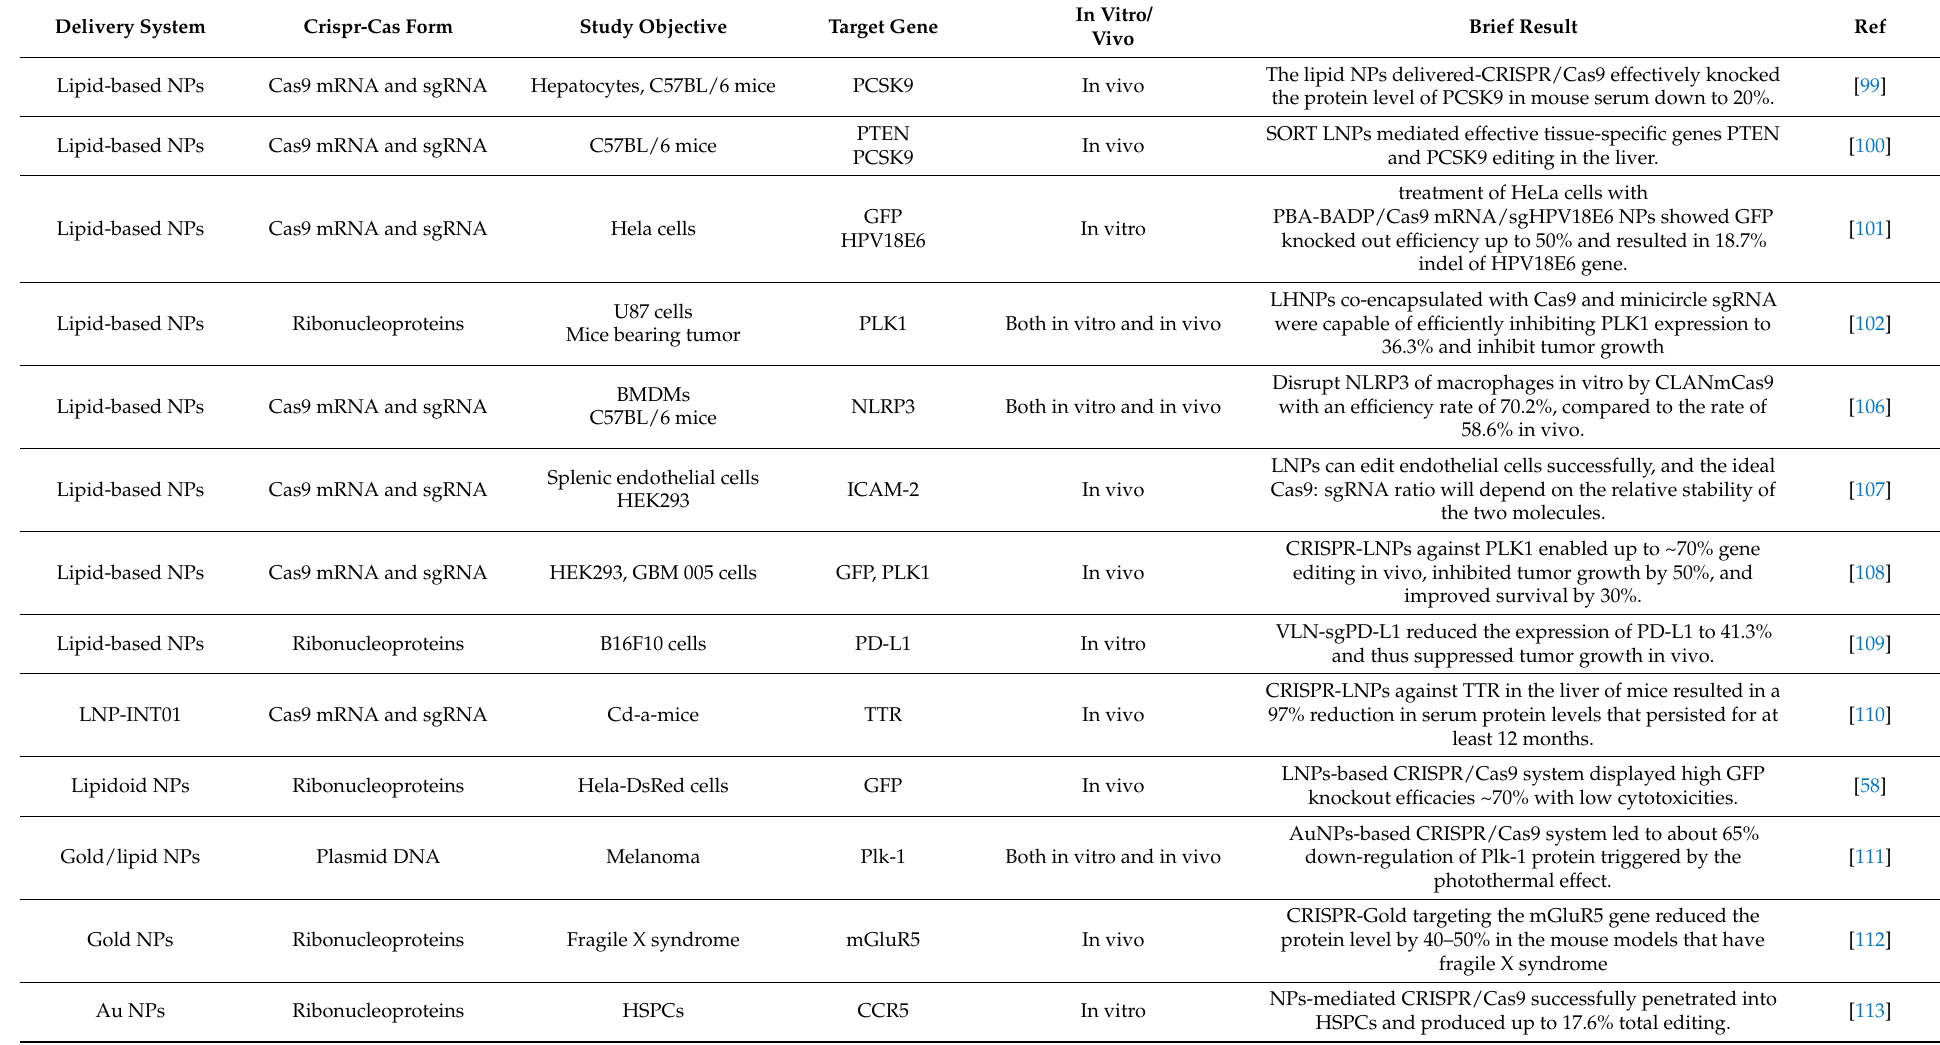
Table 1. Nanoparticle delivery systems for